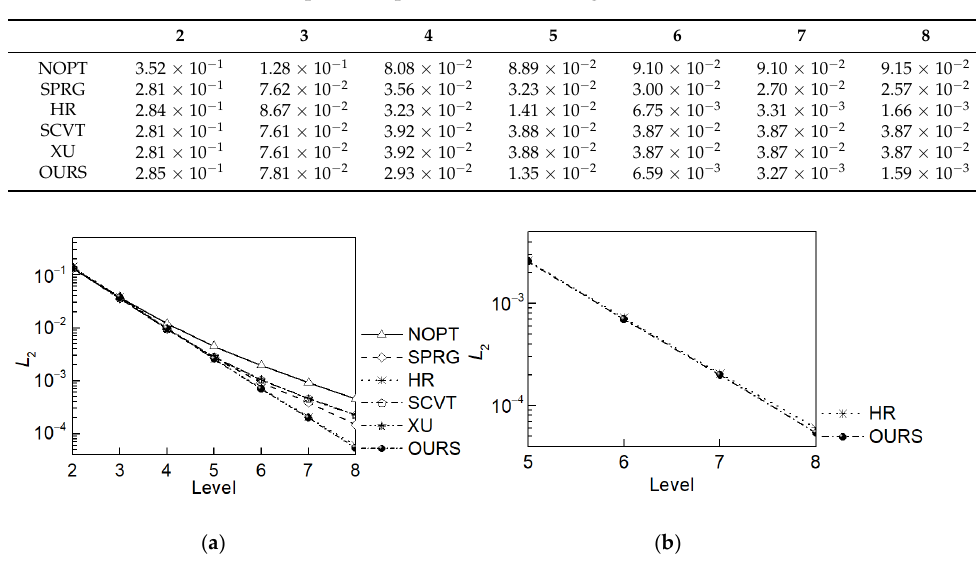
Figure 13. L 2 -norm error of Laplacian operator. ( a ) L 2 -norm error of all grids ( b ) L 2 -norm error of OURS and HR grid from level 5 to 8.